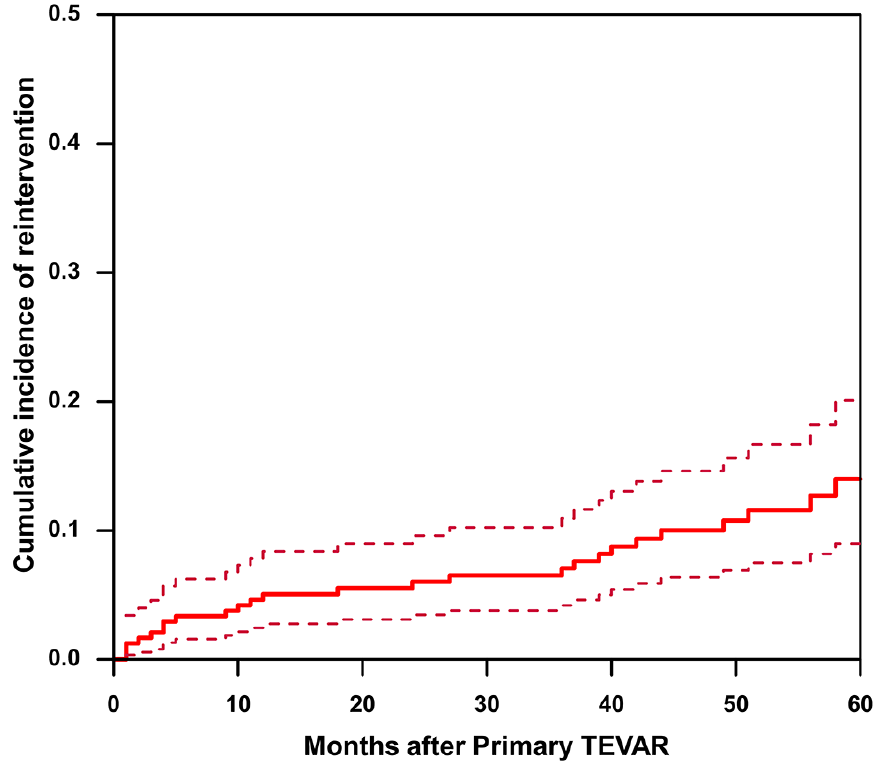
Figure 2. The cumulative incidence of reintervention after TEVAR in patients with uncomplicated type B aortic dissection. The solid line represents cumulative incidence curve. The dashed line represents the 95% confidence interval of the cumulative incidence. Table 4. Indications and descriptions of